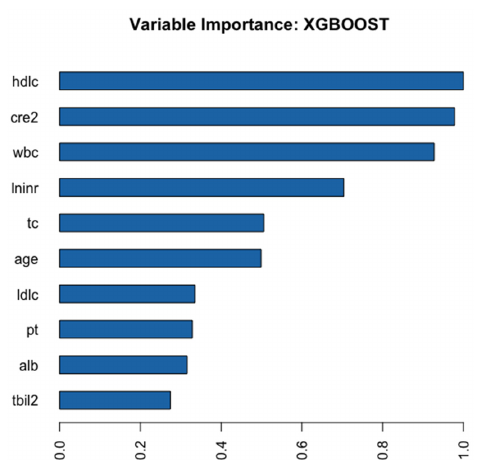
Figure 2. Relative importance of the variables in the XGBoost model. The chart shows that HDL-C was the most important variable, followed by Cre, WBC, INR, etc. Abbreviations: hdlc, high-density lipoprotein cholesterol; cre2, creatinine; wbc, white blood cell count; lninr, international normalized ratio; tc, total cholesterol; ldlc, low-density lipoprotein cholesterol; pt, prothrombin time; alb, albumin; tbil2, total bilirubin.